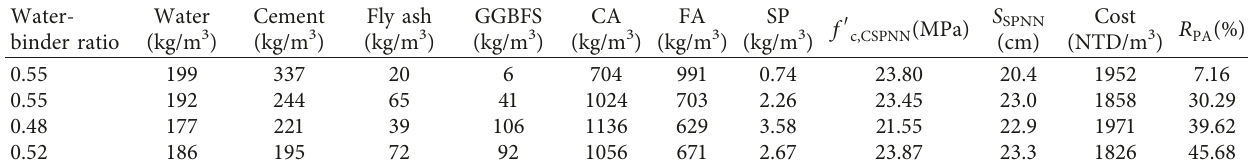
Table 12: Concrete mixture proportioning samples for compressive strength � 210kg/cm 2 and cost ≤ 2000 NTD/m 3 . Water- Water binder ratio